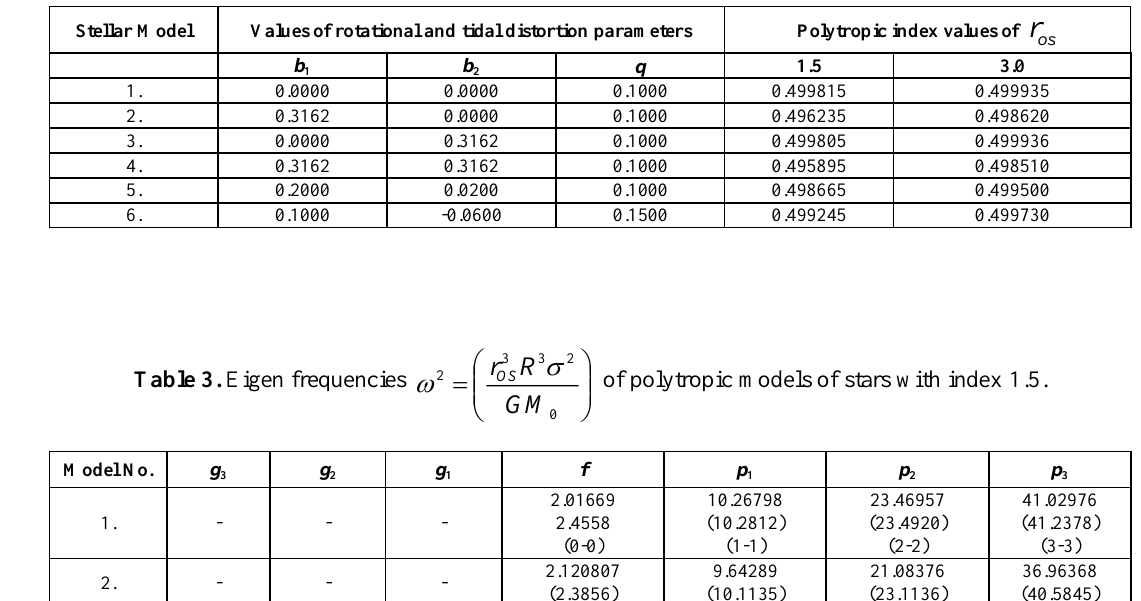
r and distortion parameters for polyropic indices 1.5 and 3.0. Table 2. Values of o s